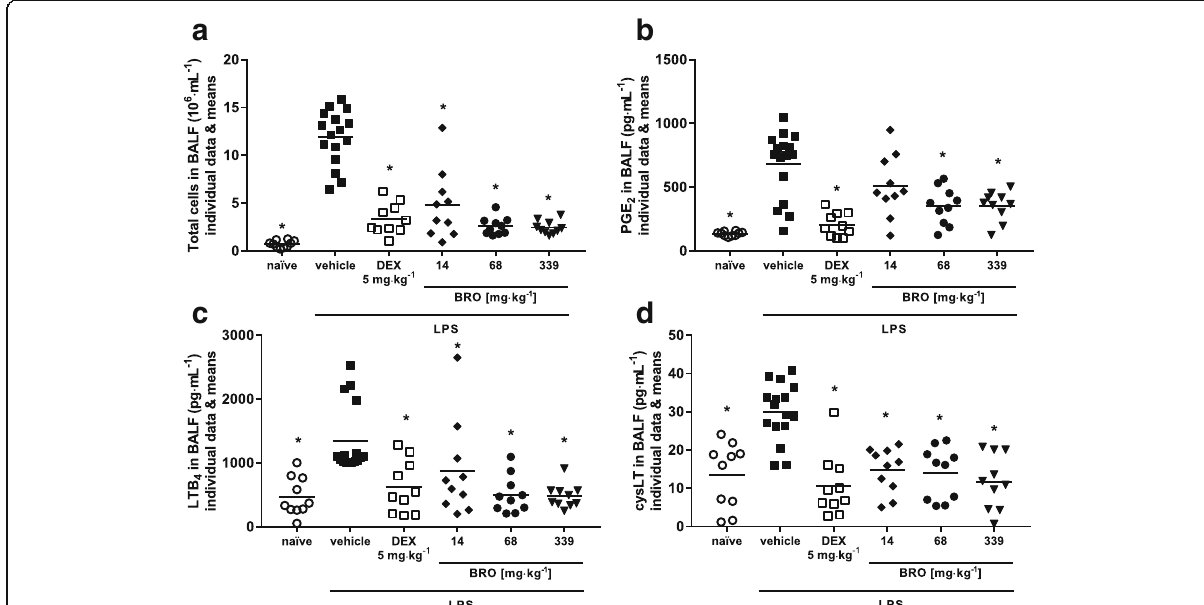
Fig. 1 Analysis of the effects of BRO on inflammatory parameters in BALF. Oral treatment with BRO significantly reduced ( a ) total cells, ( b ) PGE 2 , ( c ) LTB 4 and ( d ) cysLT levels in BALF of rats challenged intratracheally with LPS. Data are given as individual values and their means. *statistically significant versus LPS/vehicle; p < 0.05; ANOVA of log-transformed data + Dunnett ’ s